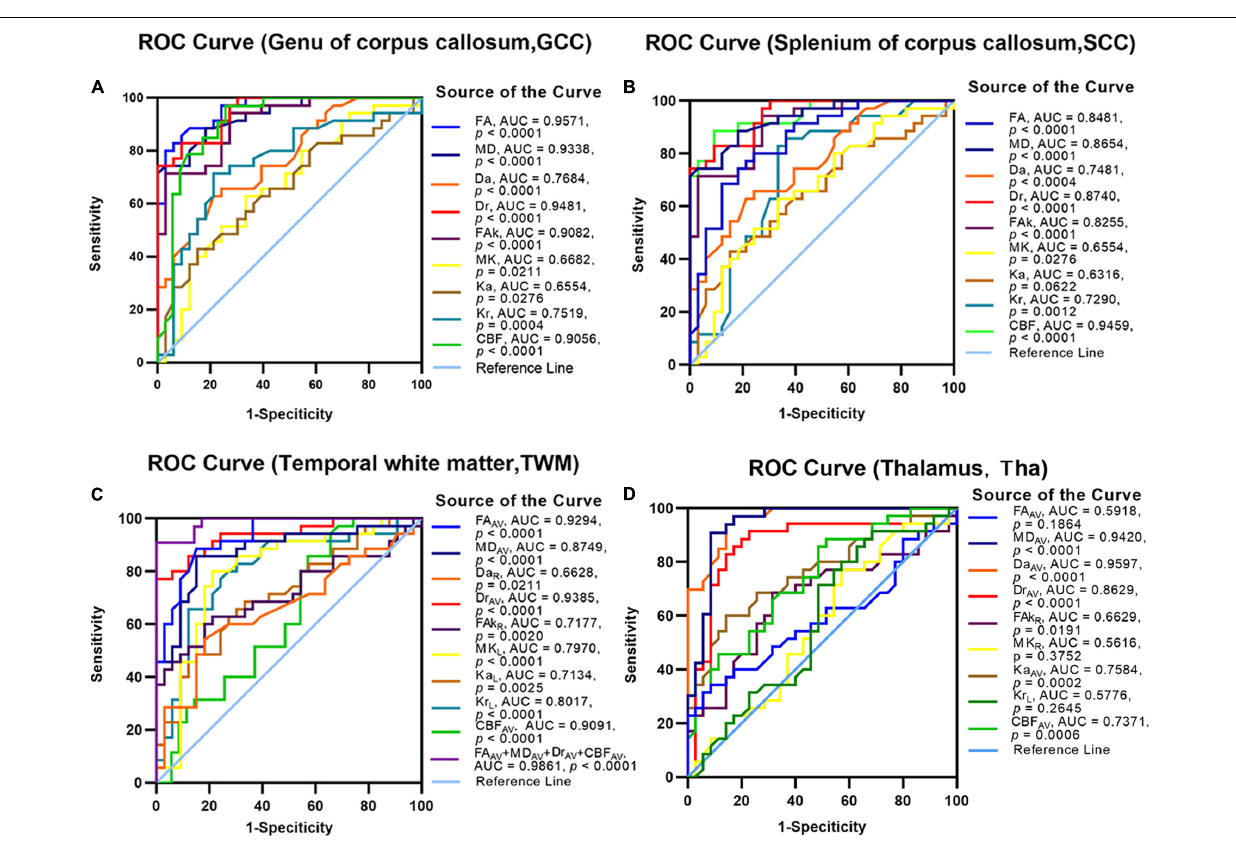
Frontiers in Neuroscience |